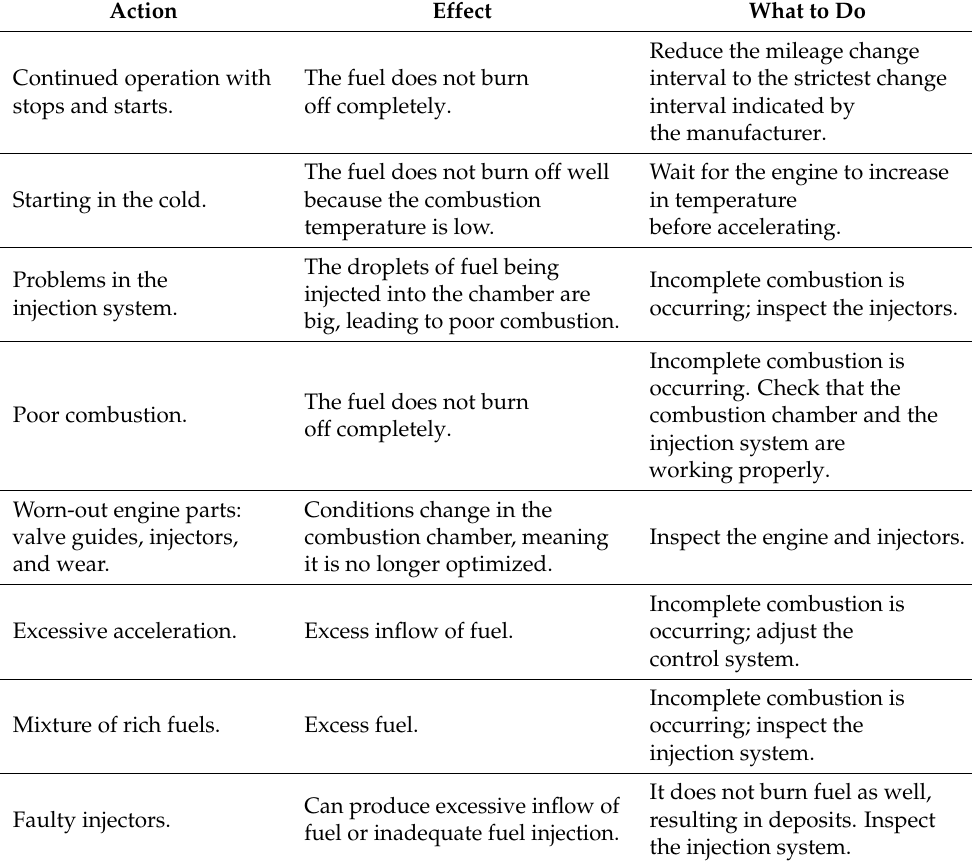
Table 1. Fuel inflow caused by mechanical effects (based on [7]).